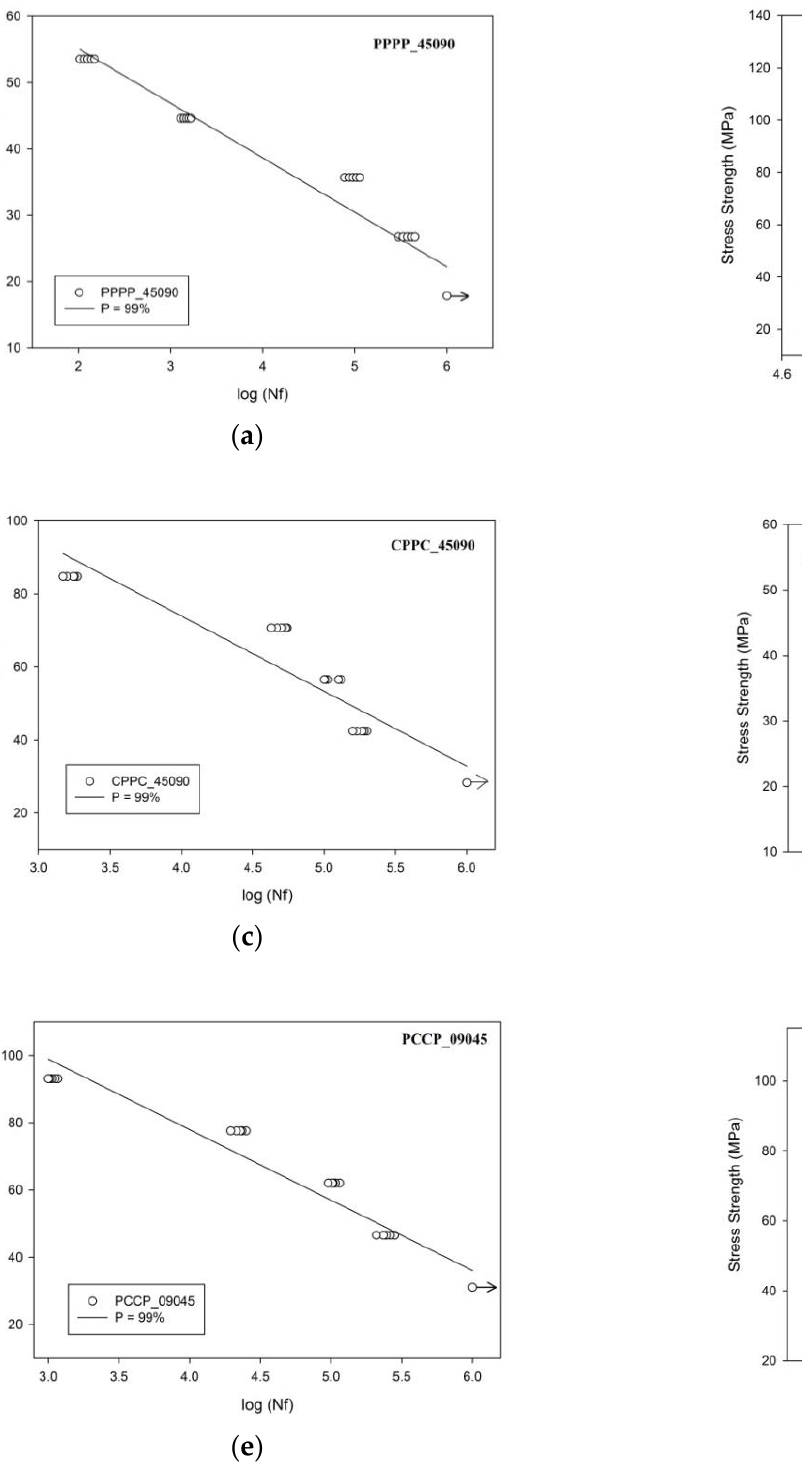
Figure 2. Experimental results and P–S–N for the laminates; ( a ) PPPP_45090, ( b ) PCCP_45090, ( c ) CPPC_45090, ( d ) PPPP_09045, ( e ) PCCP_09045 and ( f ) CPPC_09045. Table 6. Fitted data for the Wöhler’s law parameters and the linear regression coef ficient.